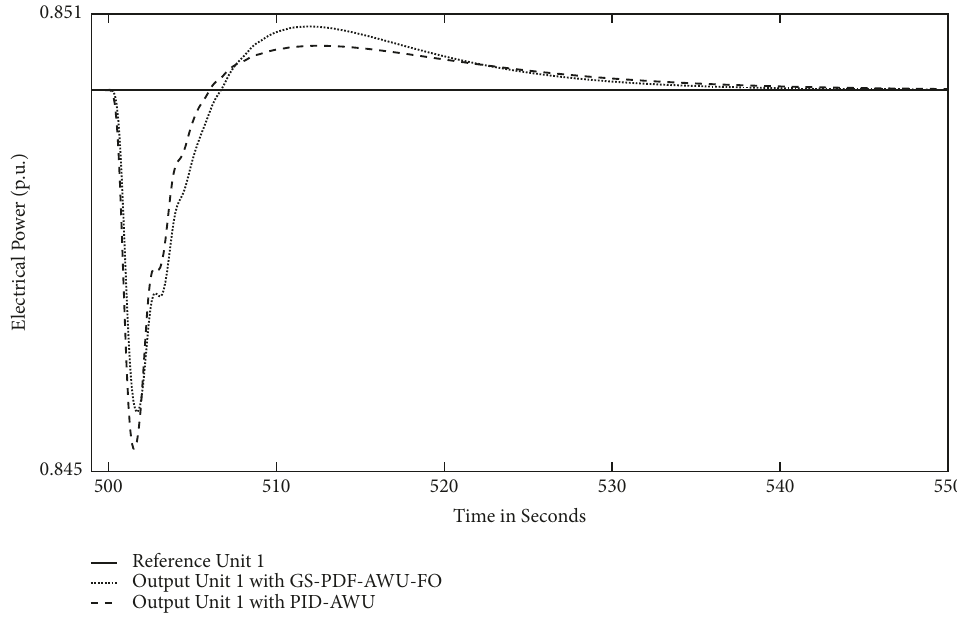
Figure 12: Cross-coupling reaction of unit 1 when unit 2 is under a step of 0.05 with 0.85 of operational point while h=1.